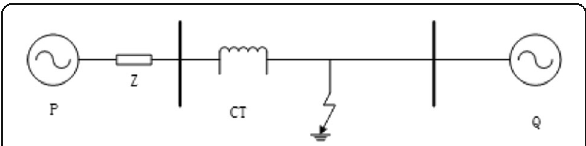
Fig. 11 Simulation circuit in PSCAD/EMTDC